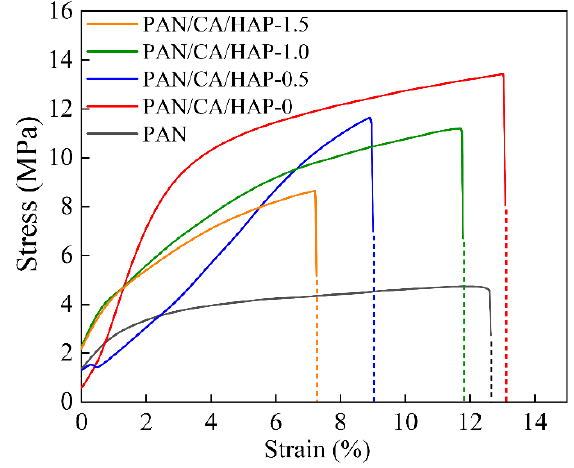
Figure 4. The stress–strain curves of different separators.